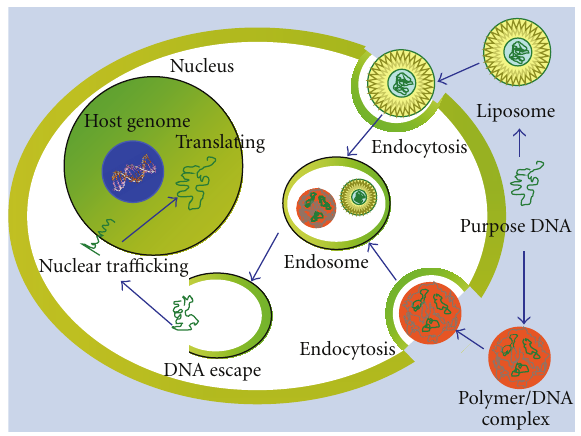
Figure 2: The mechanism of transfection using viral